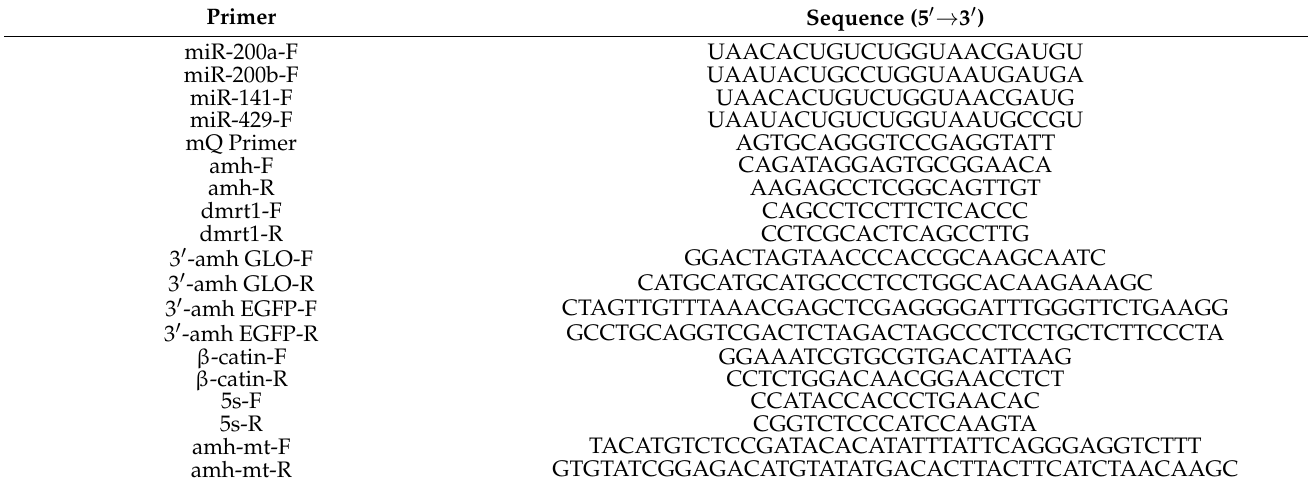
Table 1. The primers used in this